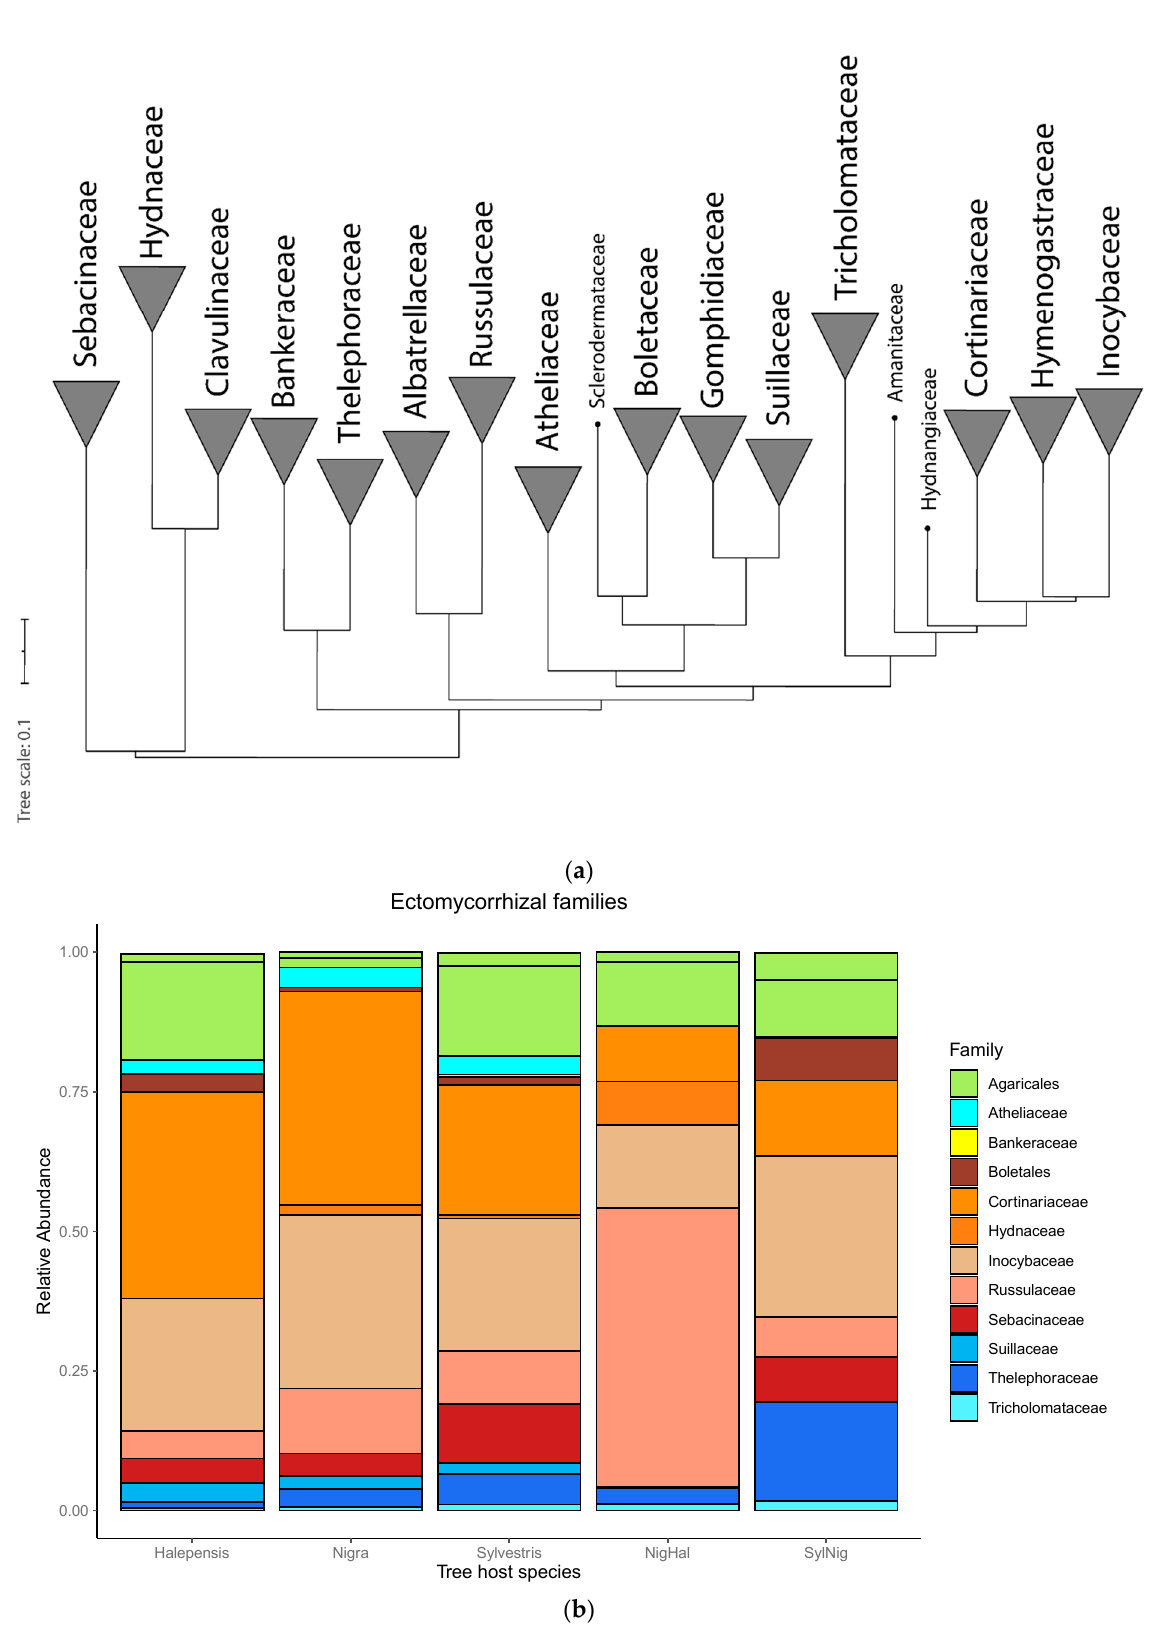
Figure 1. ( a ) The hybrid phylogenetic tree of ectomycorrhizal families based on the foundation phylogeny derived by Zhao et al., (2017), based on the sequences of six genes 18sS rRNA, 28S rRNA, 5.8S rRNA, translation elongation factor 1- α (tef1 α ) and RNA polymerase II. ( b ) Relative abundance of the most abundant ectomycorrhizal families.